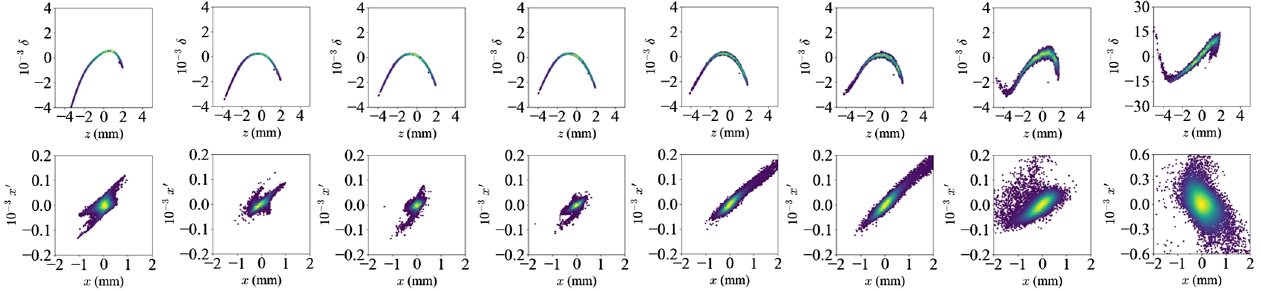
FIG. 27. Simulated x − x 0 and z − δ distributions after each of the 8 LINAC passes for CBETA 4-turn with Q ¼ 1 pC.